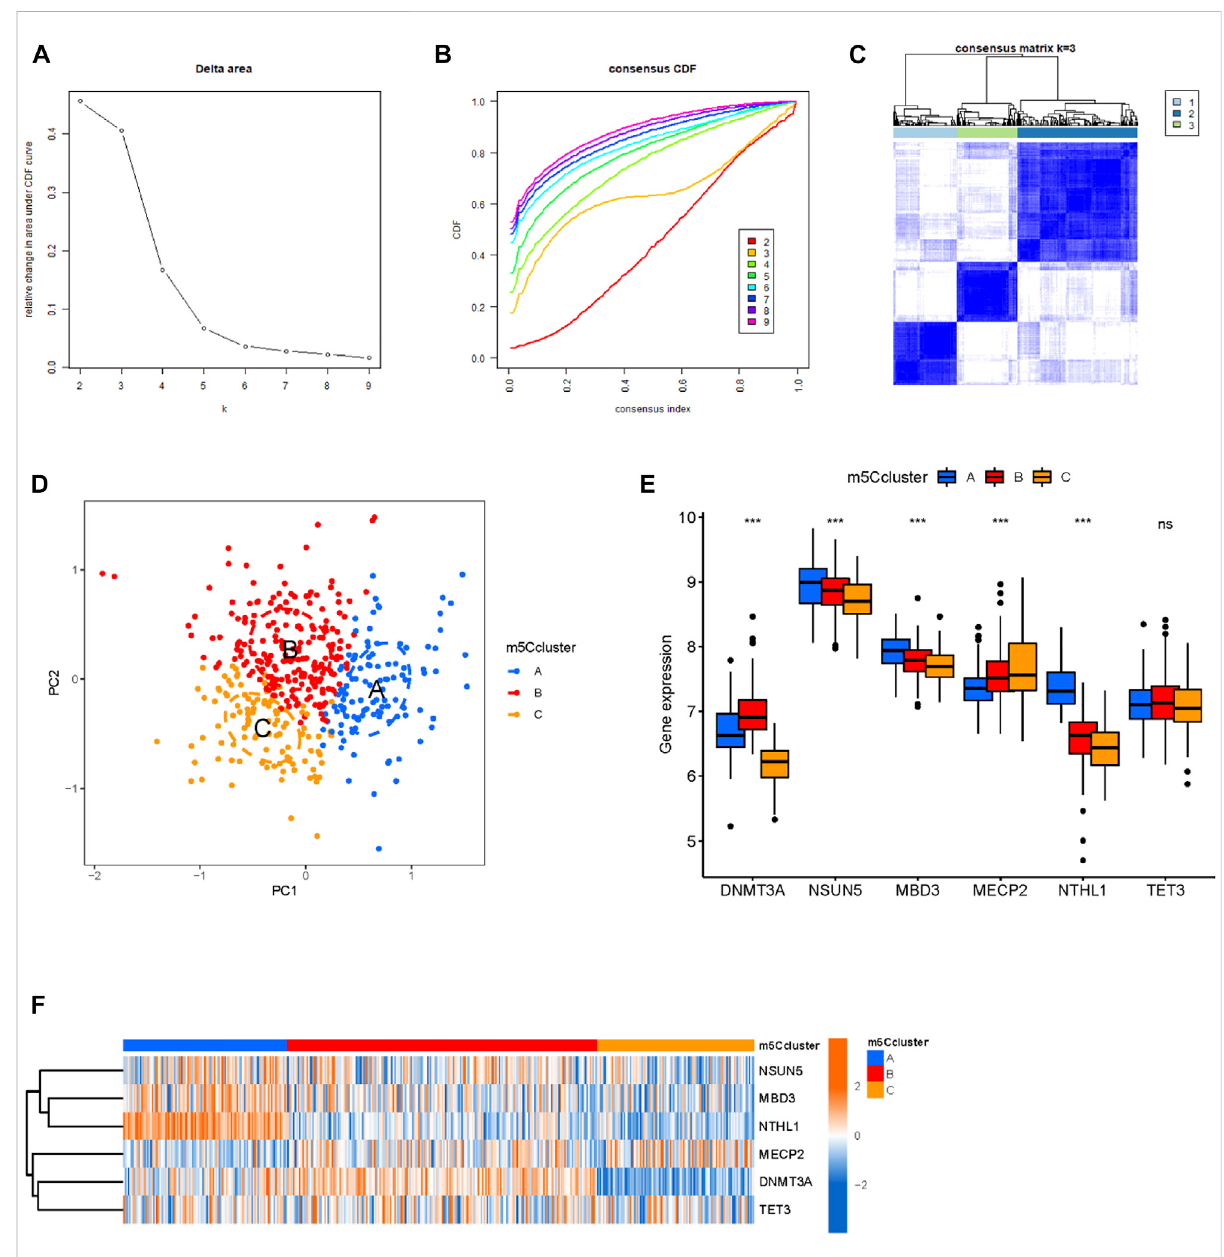
FIGURE 4 Establishmentofm 5 Cmethylationmodi fi cationpatterns. (A) Consensus clustering ofthecumulativedistributionfunction(CDF)fork=2 – 9. (B) Elbow plot showed the relative change in the area under the CDF curve. (C) The consensus heatmap de fi ned three m 5 C clusters in 423 patients with MM. (D) PCA of the m 5 C clusters in MM patients. (E,F) Boxplot and heatmap showed the expression levels of m 5 C regulators among the three m 5 C